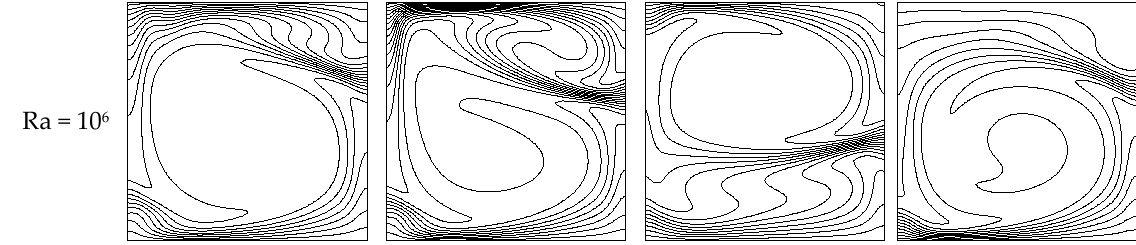
Figure 6. Evolution of isotherms over a period as a function of the Rayleigh number (Amp = 0.2 and |f| = 0.33 × 10 − 4 ).